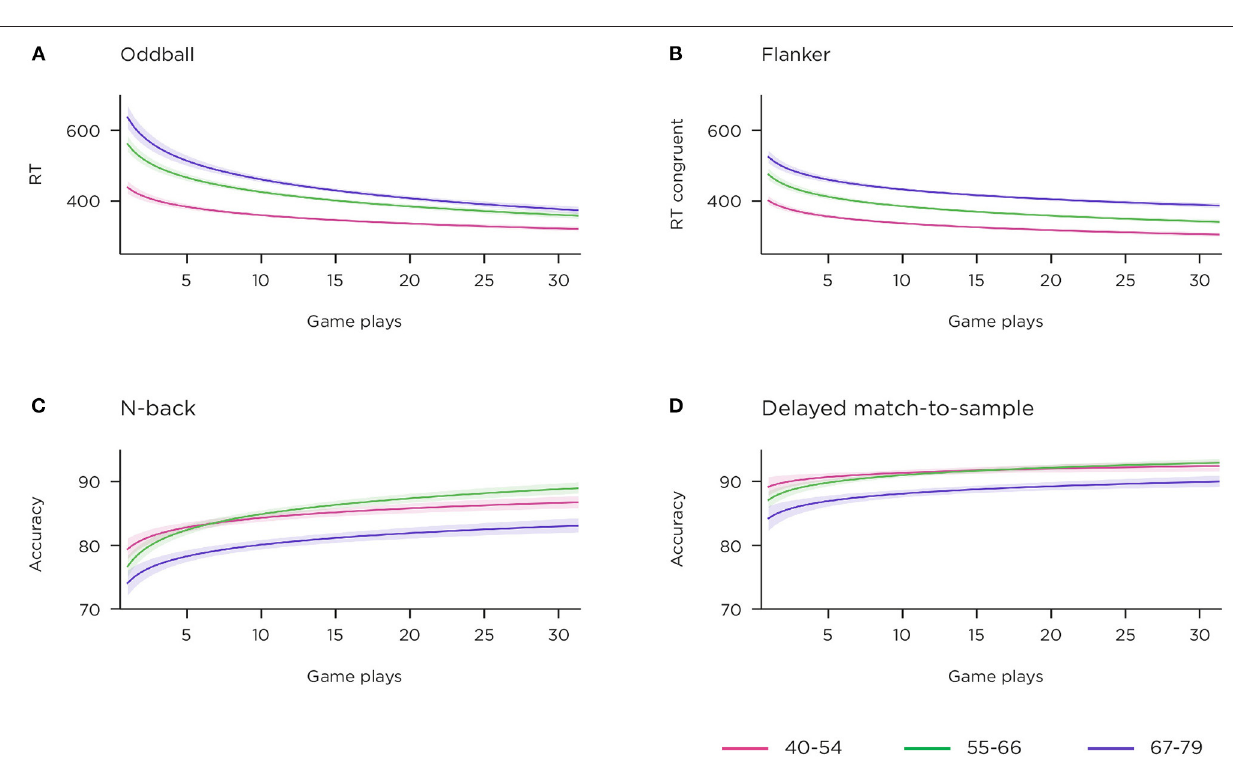
FIGURE 6 | Behavioural responses to gamified cognitive tasks over 12 weeks across age group. Shading indicates 95% confidence interval. (A) median correct RTs to targets in 2-stimulus oddball task; (B) median correct RTs to congruent trials in flanker task; (C) percentage accuracy, all trials, n-back task; (D) percentage accuracy, all trials, delayed match-to-sample